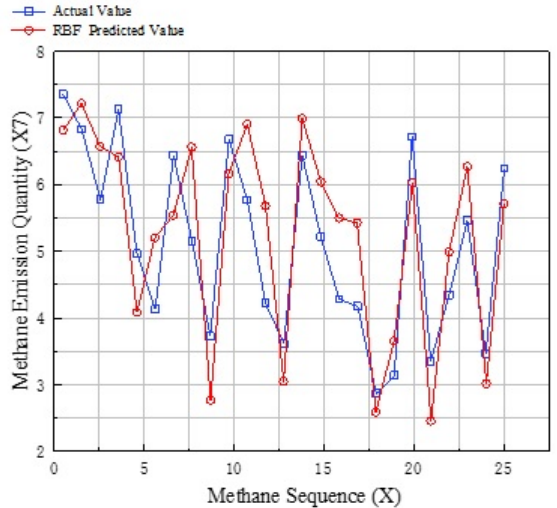
Figure 5. Comparison between RBF the neural network model predicted value and actual value.